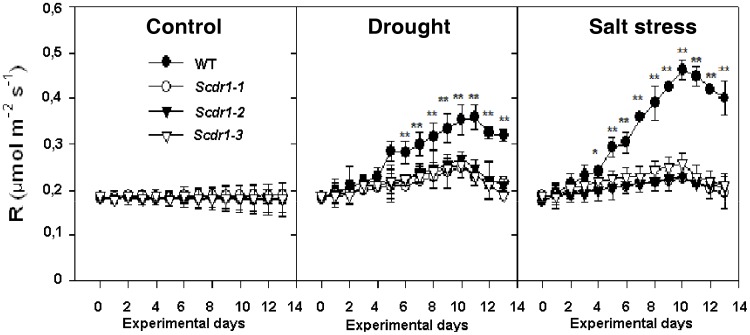
Respiration in tobacco leaves exposed to drought and salt stress.Thirty-day-old WT and transgenic plants were exposed for 10 days to 200 mM mannitol or 175 mM NaCl and were then allowed to recover for three days by watering with pure water. The data shown represent the means of three replicate measurements. Asterisks (** and*) indicate significant differences relative to WT plants in each treatment and each time point (P<0.0001 and P<0.01, respectively, n = 5).